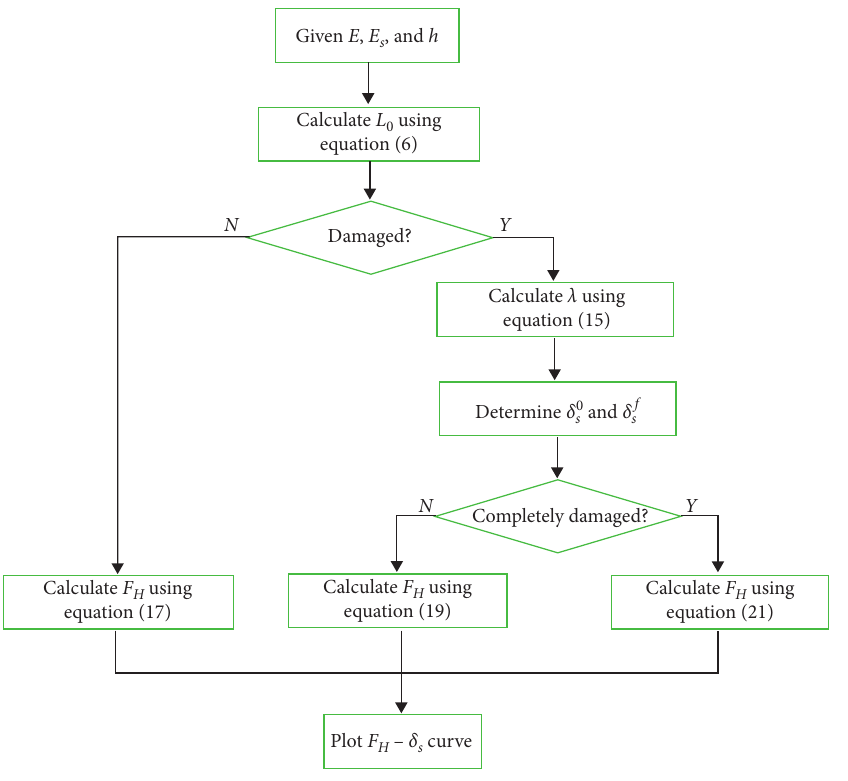
Figure 4: Flowchart of the use of the linear proportional distribution method.